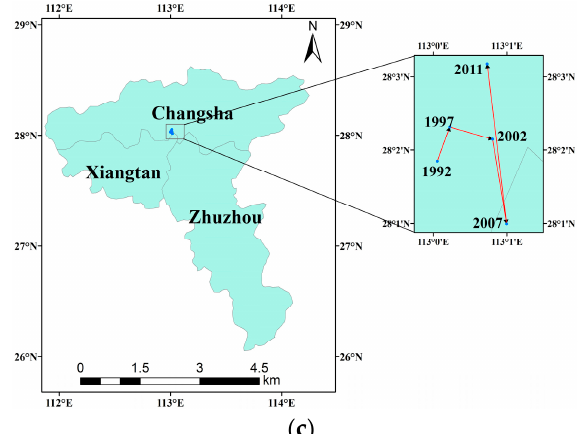
Figure 9. The trajectory of the gravity center of urban extents in three urban agglomerations: ( a ) Wuhan metropolitan area, ( b ) Poyang lake city group, and ( c ) Chang-Zhu-Tan urban agglomeration.